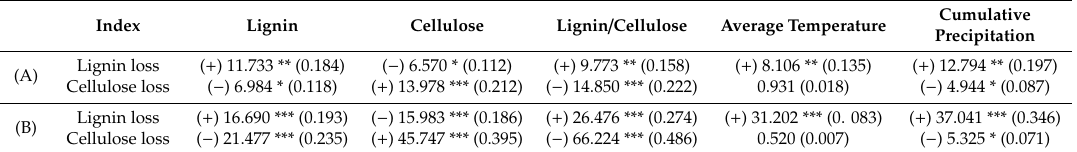
Values are the F -value and determination coe ffi cient ( R 2 , in parentheses) for regression analysis with loss rate as the response variable and changes in chemical traits or environmental factors as predictor variables over the 360-day decomposition experiment. ( + ) or ( − ), significance: * p < 0.05; ** p < 0.01; *** p < 0.001; n = 54 (A); n = 72